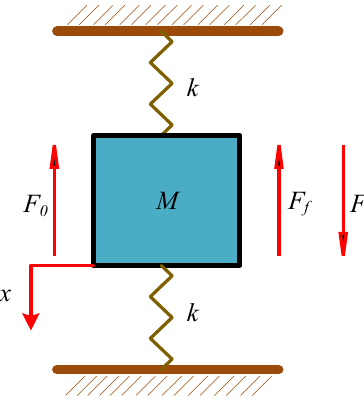
Figure 2. Stress analysis of magnetic actuator mover.